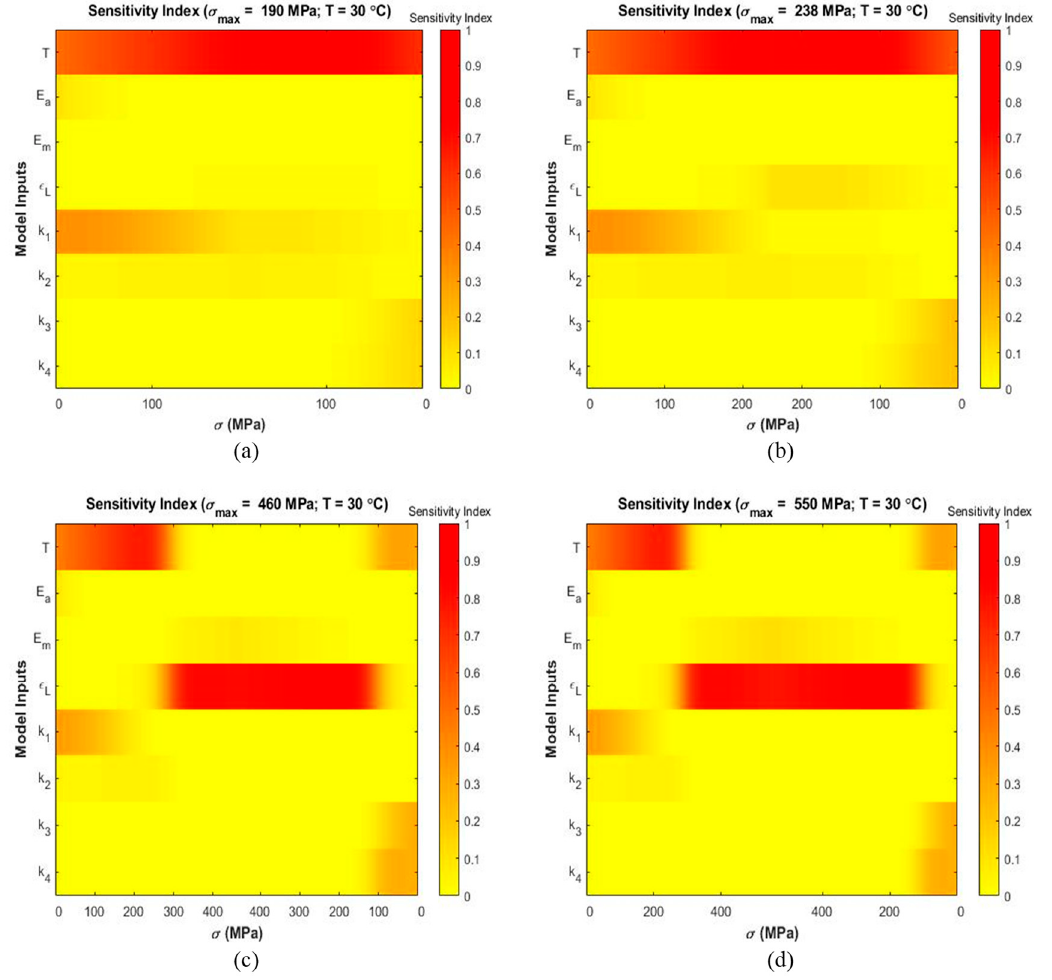
Figure 7. Sensitivity index distribution during loading and unloading based on eFAST sensitivity analysis at simulated temperatures (the corresponding stress values are shown in horizontal axis and the inputs are shown in vertical axis): ( a ) T = 30 ◦ C, σ max = 190 MPa ( b ) T = 30 ◦ C, σ max = 238 MPa